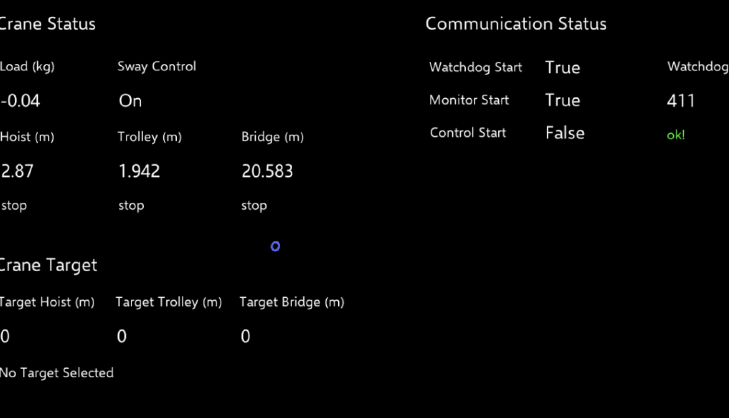
Figure 5. Screen capture of the dashboard from the Unity project in the play mode: the information displayed in the dashboard consisted of three sections, the “Crane Status”, “Crane Target” and “Communication